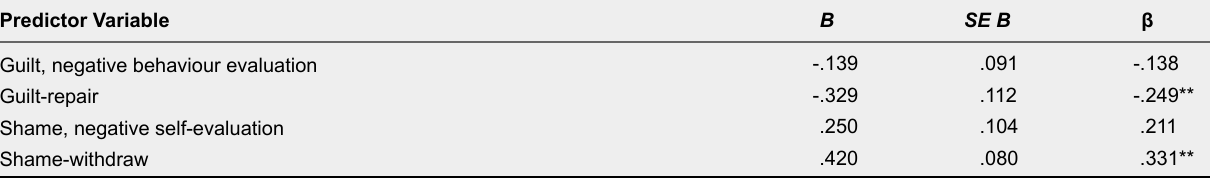
Standard Multiple Regression: Vulnerable Narcissism Predictor Variable B SE B β Guilt, negative behaviour evaluation -.139 .091 -.138 Guilt-repair -.329 .112 -.249** Shame, negative self-evaluation .250 .104 .211 Shame-withdraw .420 .080